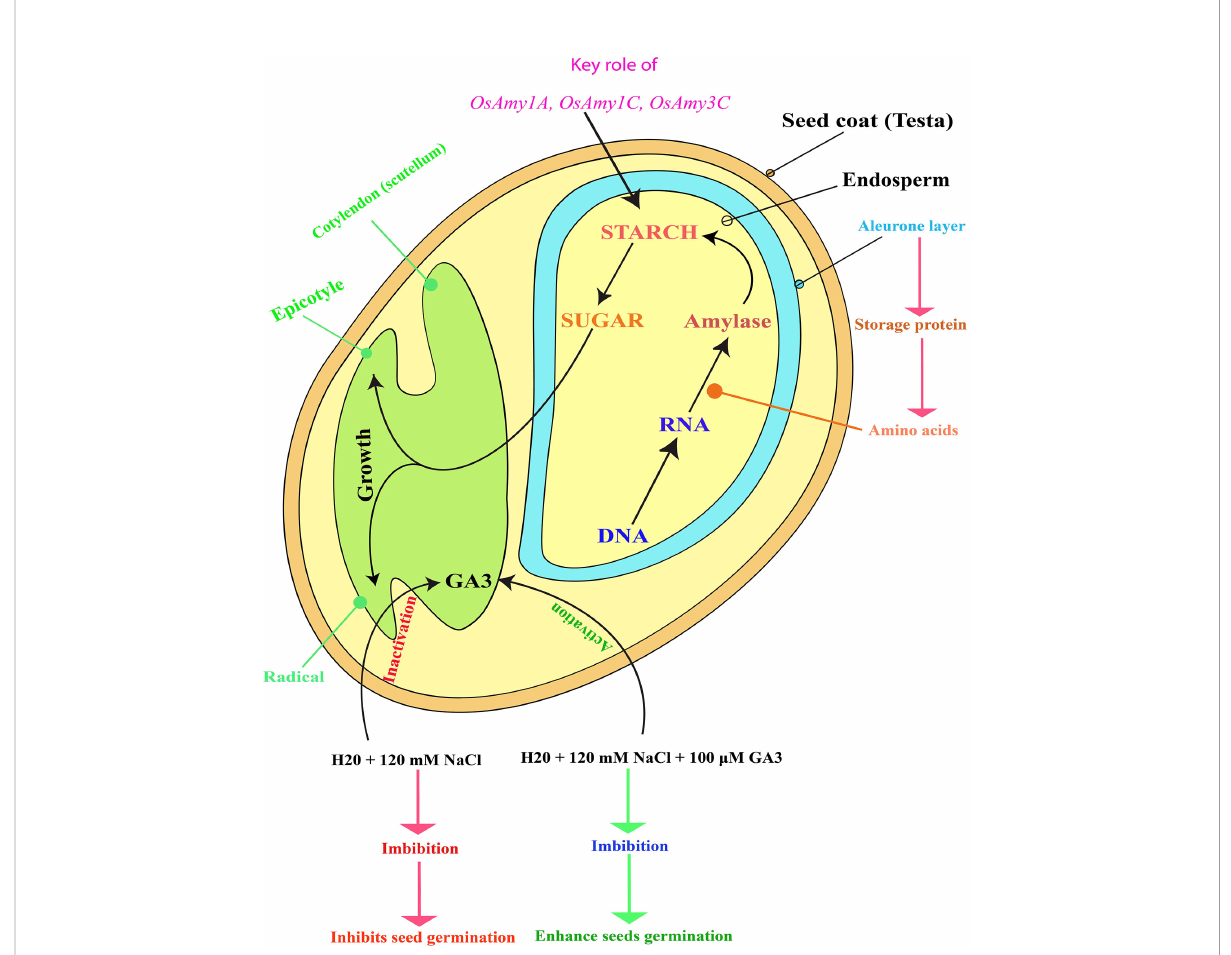
FIGURE 1 Schematic representation of rice ( Oryza sativa L.) seed structure, depicting how salinity stress inactivates endogenous GA3, leading to the inhibition of both rice seed germination and seedling growth. Figure adapted from (Koning, 1994; Ma et al., 2017). Exogenous GA3 application reactivates endogenous GA3, enhancing rice seed germination and seedling growth. GA3 activation also upregulates the a -amylase genes ( OsAmy1A , OsAmy1C , and OsAmy3C ) that may help to degrade starch contents and convert them into sugar. Later, this sugar serves as food for young plants (embryos) in which seed germination and seedling growth is restored. In the diagram, the red color letter indicates the suppression of seed germination and inactivation of GA3, whereas the green color represents the stimulation of seed germination and activation of GA3. The pink color indicates the activation of the a -amylase genes, which prevented seed germination due to the saline